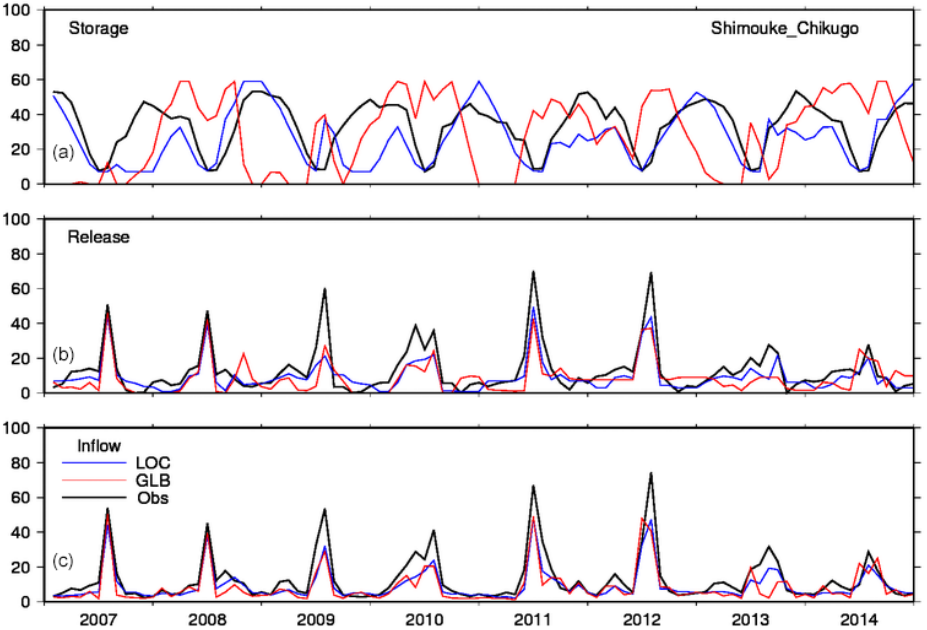
Figure 7. Reservoir operation at the Shimouke Dam on the Chikugo River. (a) Monthly time series of water storage (10 6 m 3 yr − 1 ).